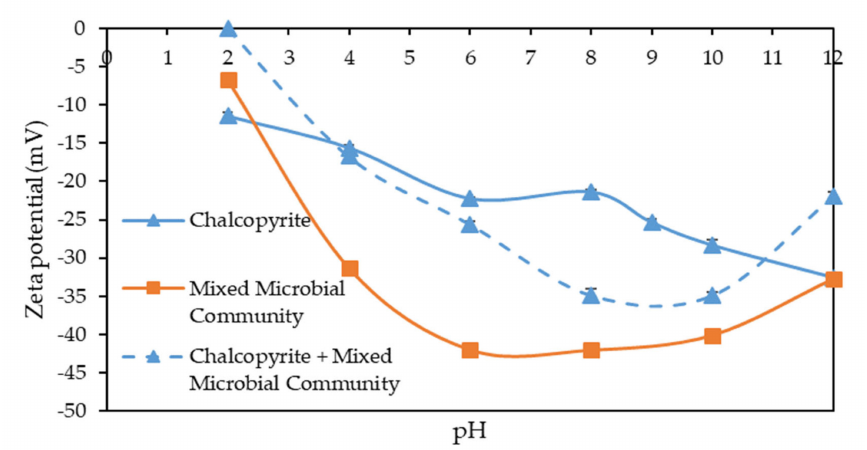
Figure1. Zetapotentialsofchalcopyrite, microbesandchalcopyriteafterinteractionwith1 × 10 8 cells / mL of mixed microbial community.